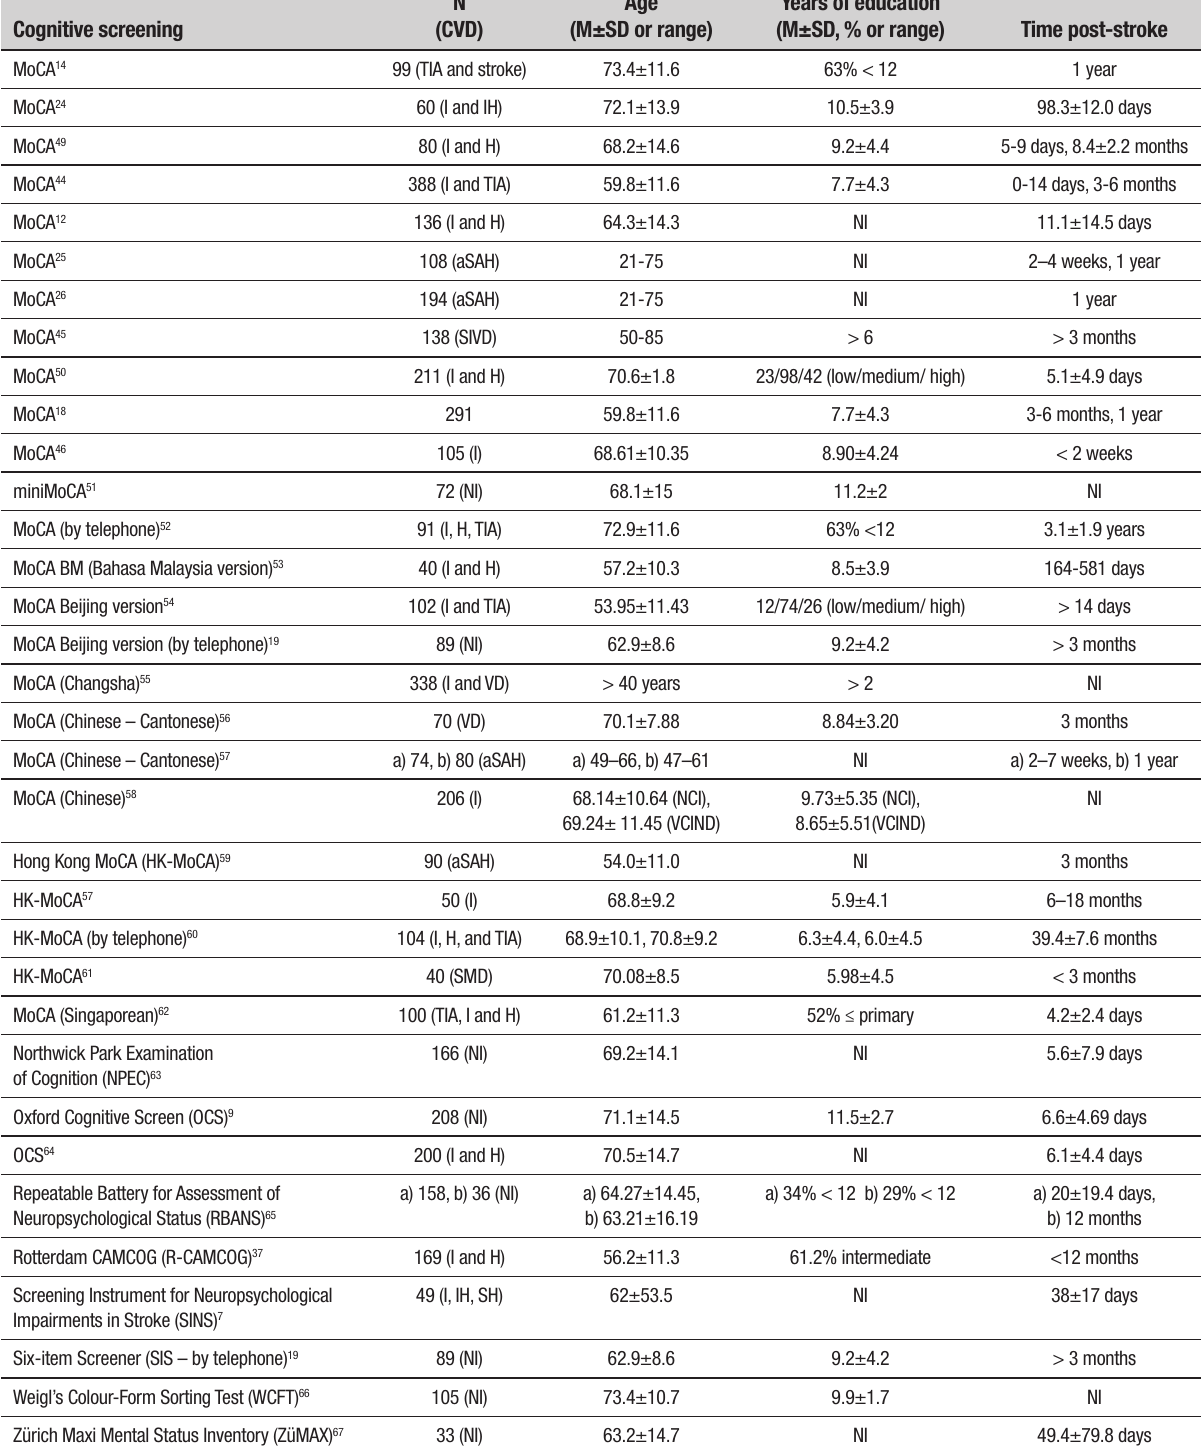
Table 1. Cognitive screening and characteristics of the samples